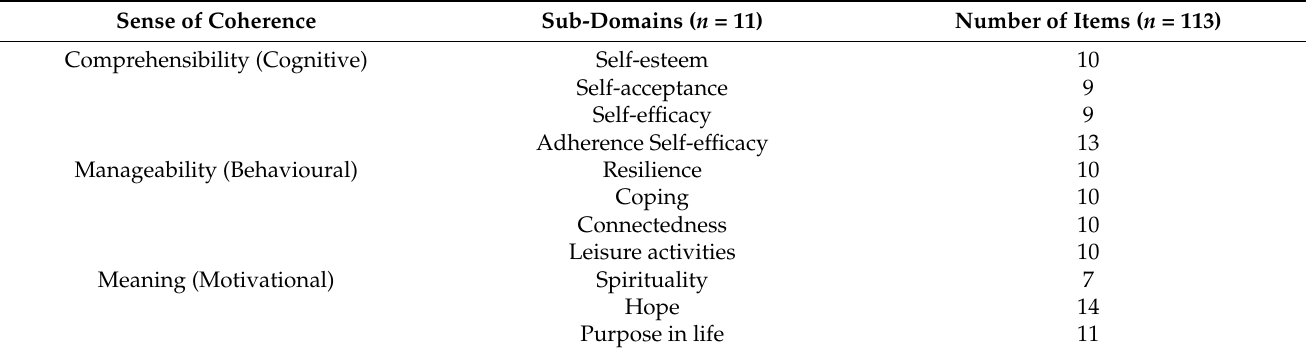
Table 1. Mental wellness domains for the